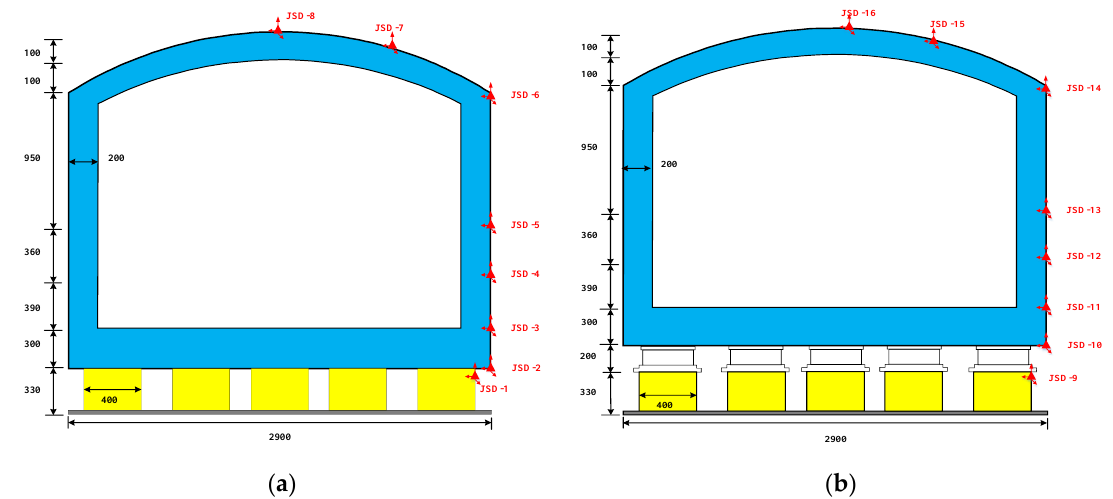
Figure 1. The plans of the storage tank: ( a ) seismic storage tank; ( b ) isolation storage tank (units: mm).